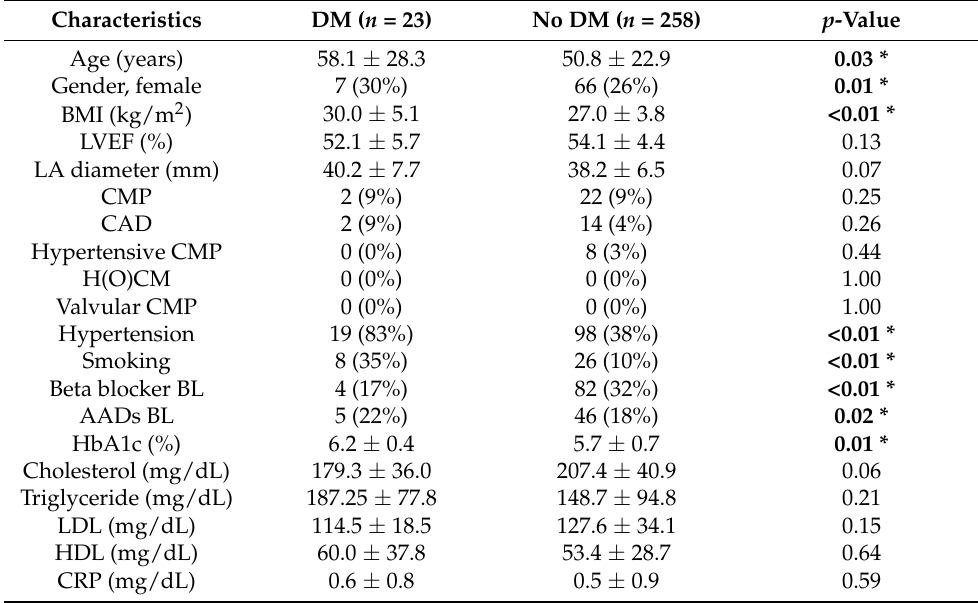
Table 2. Baseline Characteristics in PAF depending on